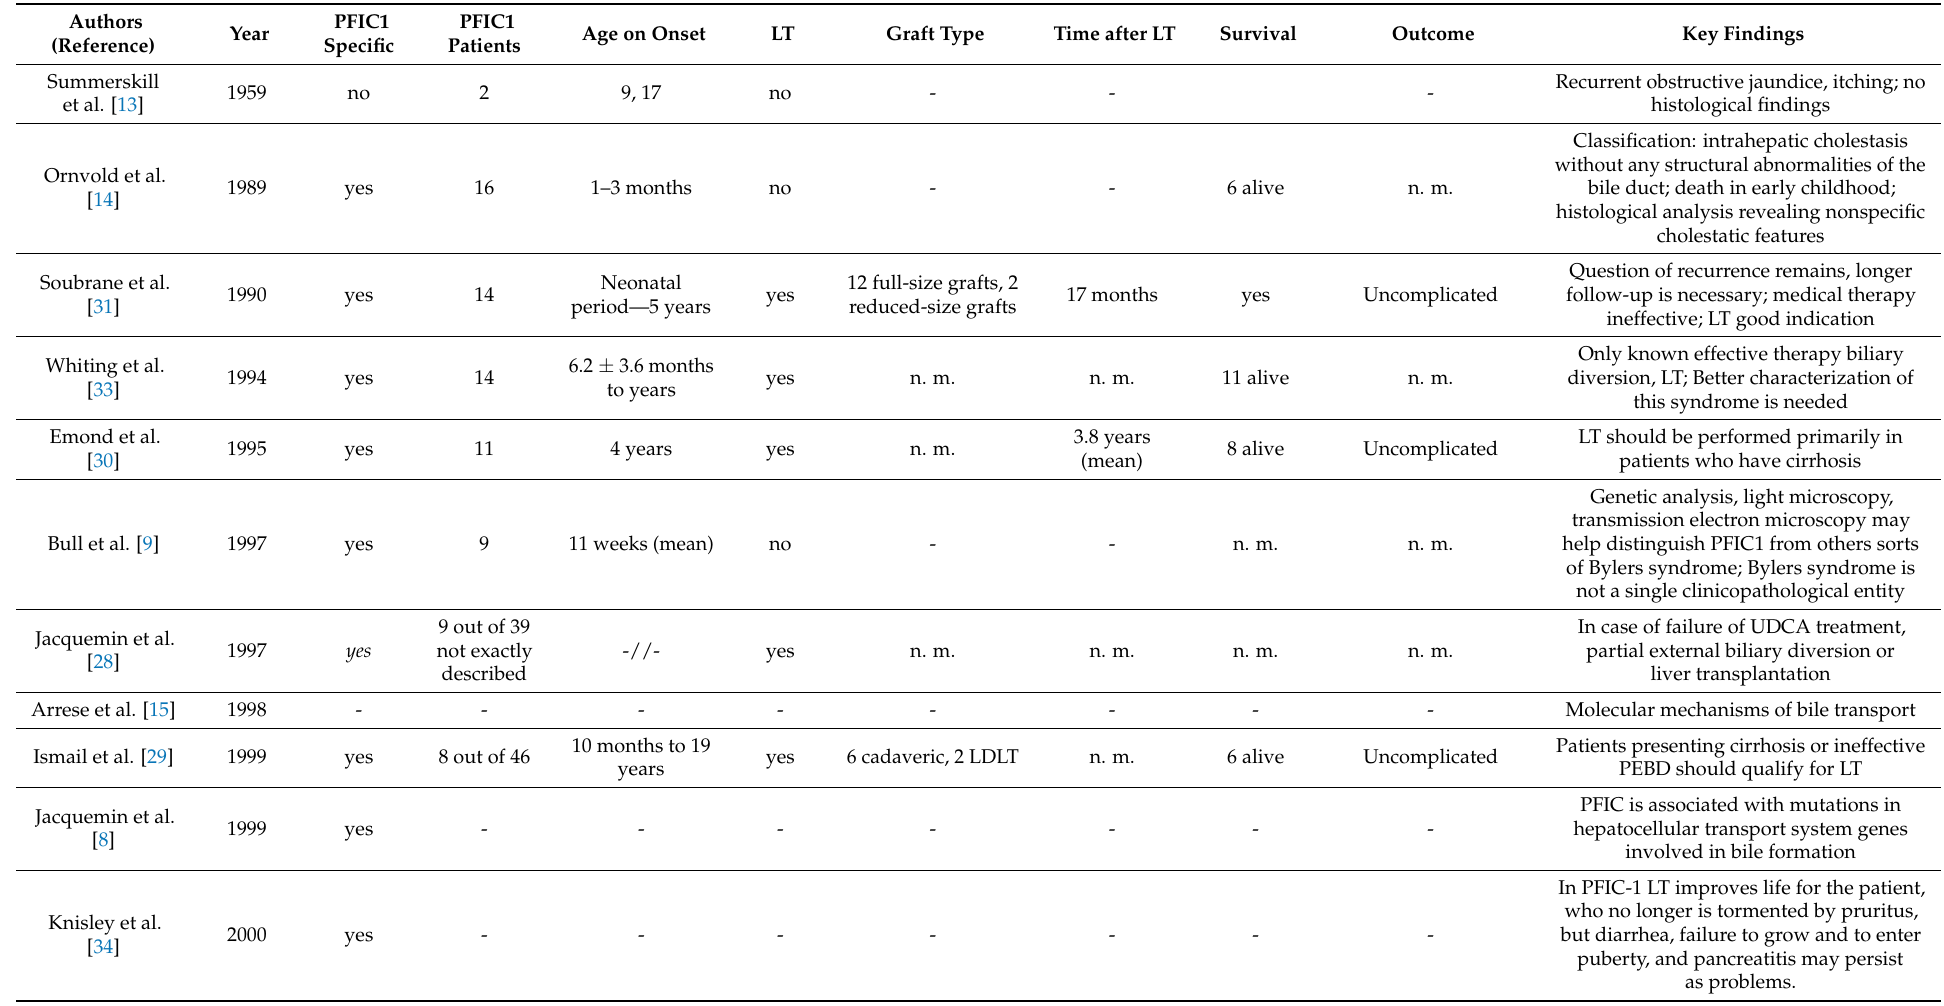
Table 5. Review of the included literature specifically for PFIC1 patients after liver